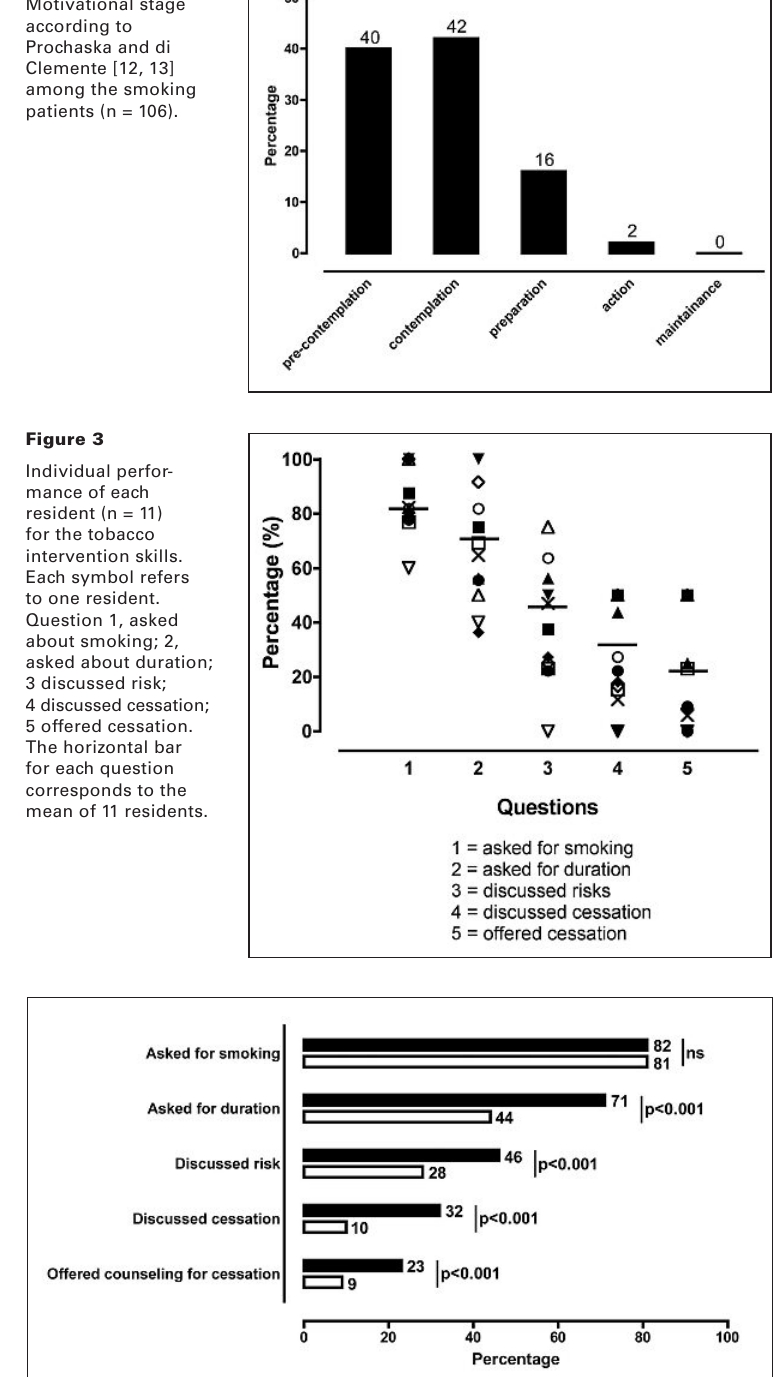
Motivational stage according to Prochaska and di Clemente [12,